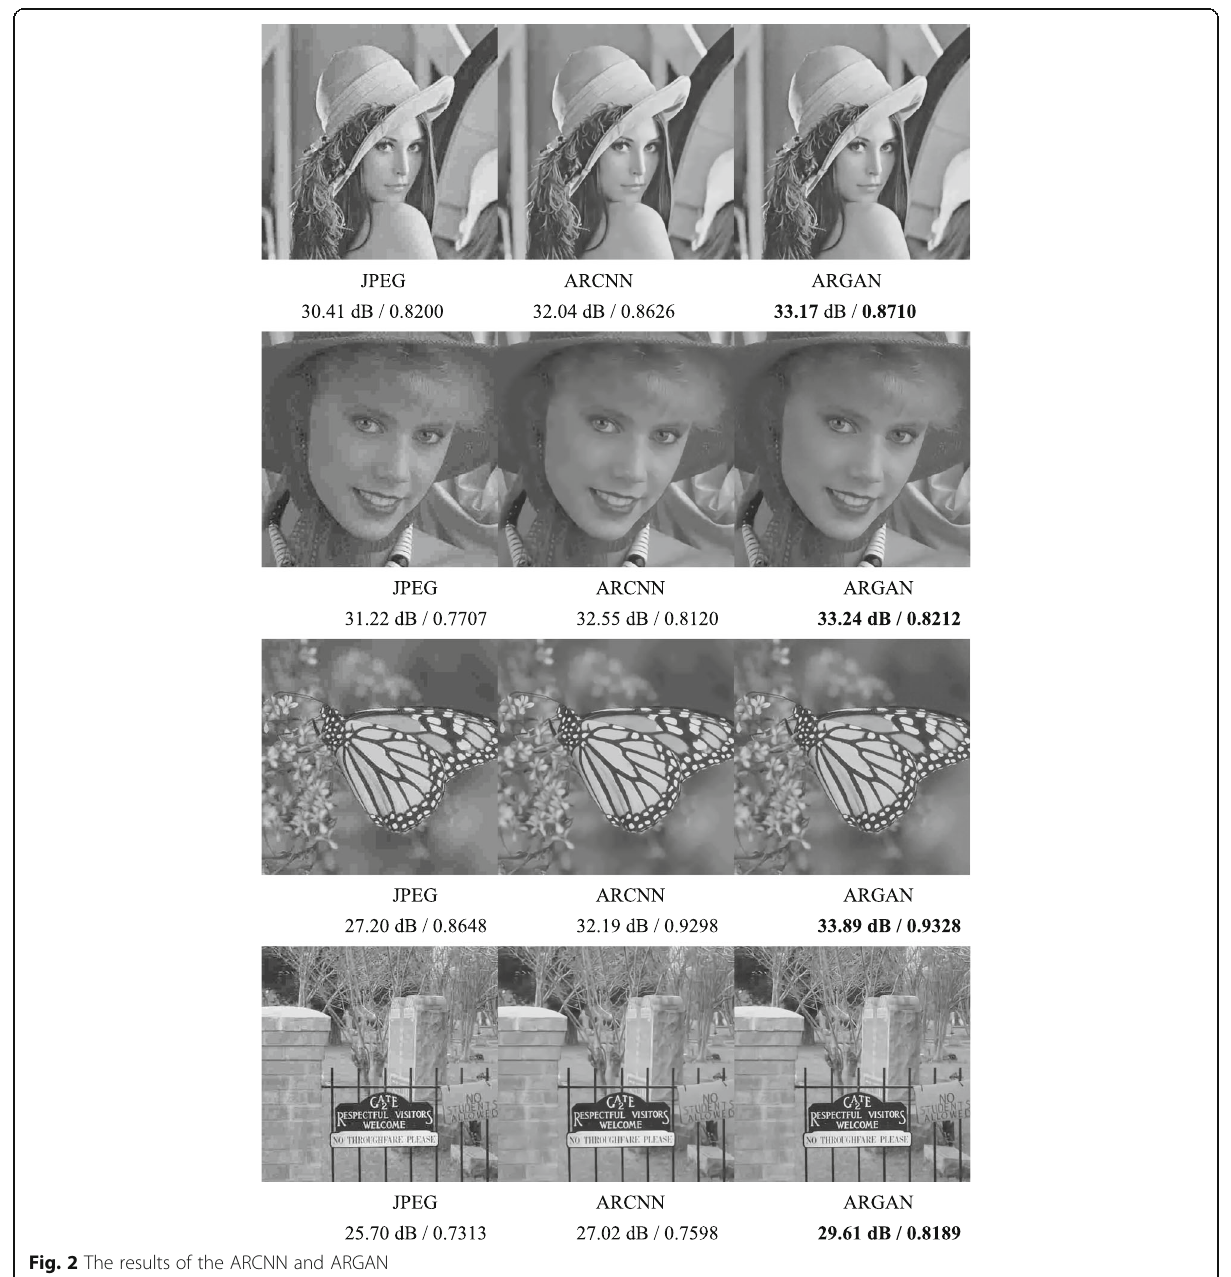
Fig. 2 The results of the ARCNN and